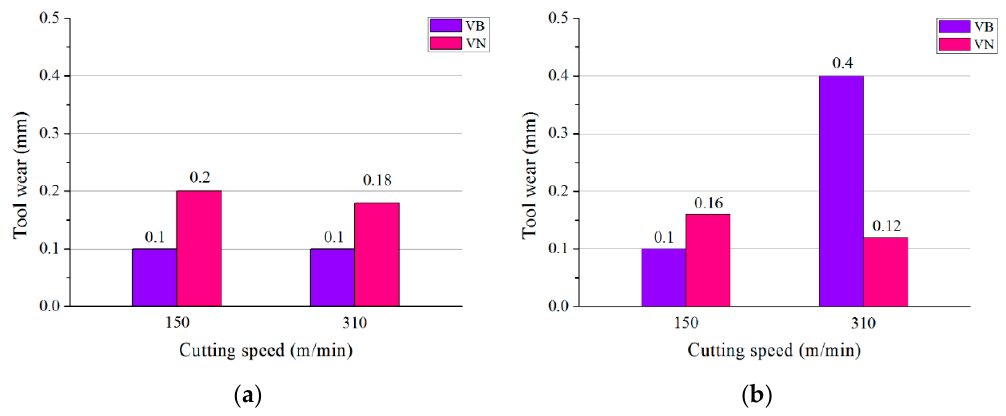
Figure 1. Tool wear of ceramic tools after 30 s of cutting: ( a ) WG300; ( b ) SX9. Table 3. Cutting parameters applied in the tool wear